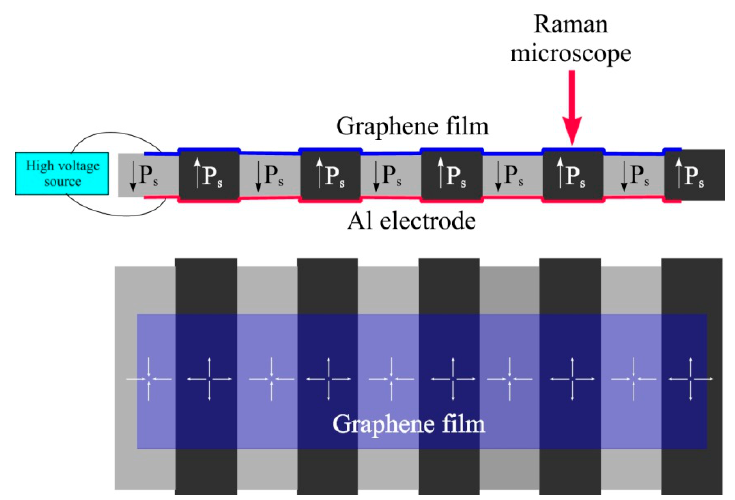
Figure 1. Schematic representation of the sample (cross-section and top-down view).